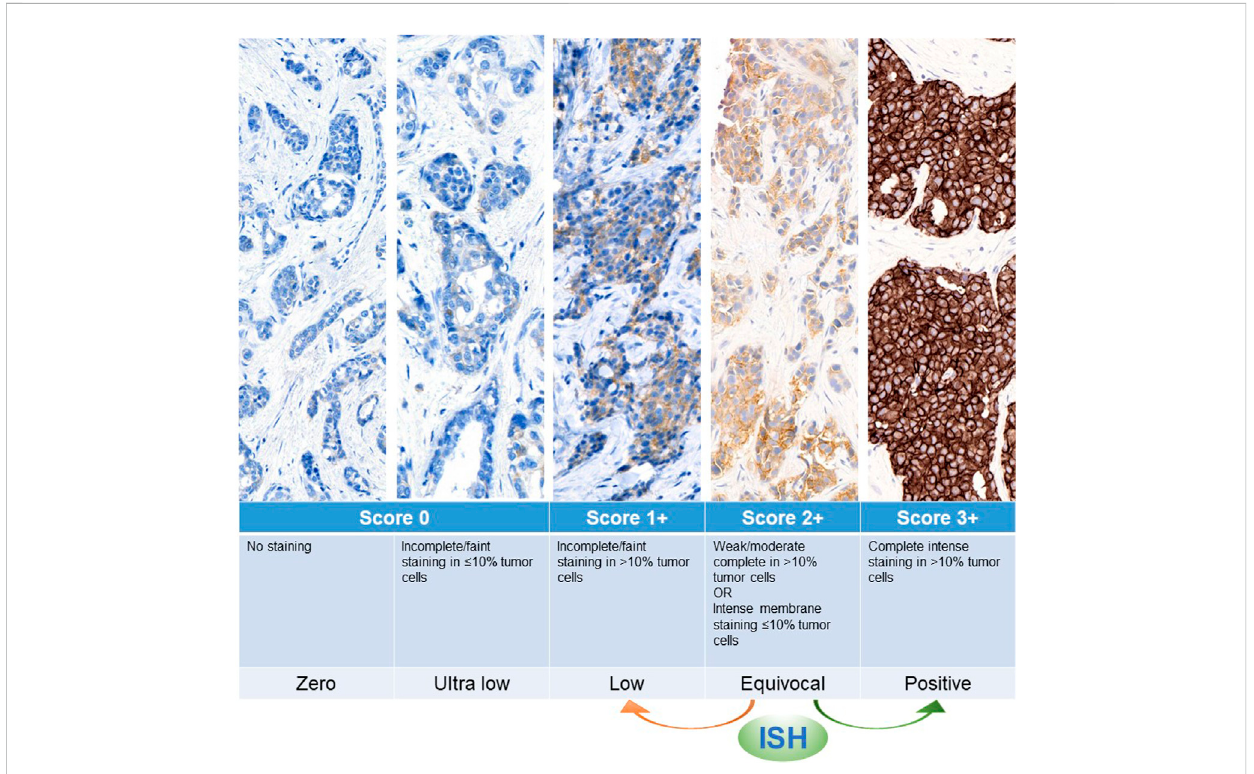
FIGURE 1 Graphical representation of HER2 expression spectrum, with score de fi nition and interpretation according to ASCO/CAP guidelines. ISH, in situ